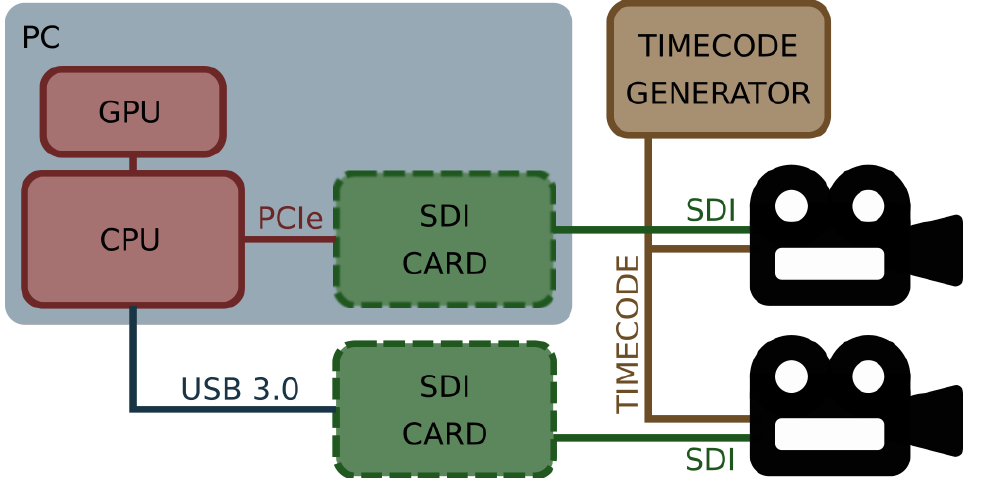
Figure 1. Architecture of the GPU-based diagnostic system for stereoscopic